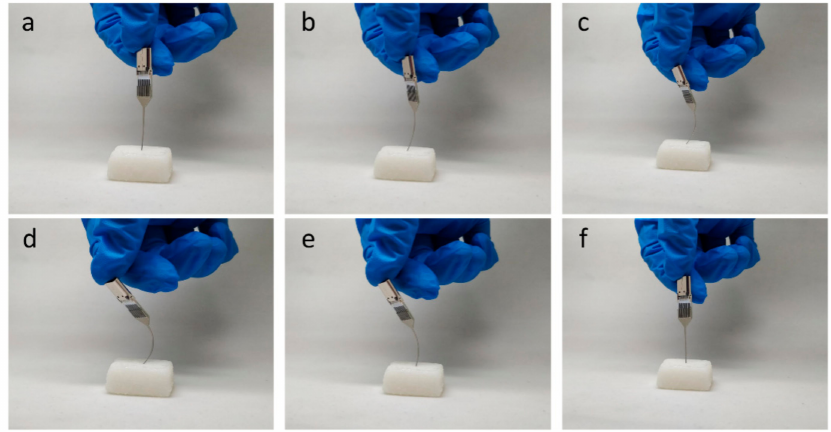
Figure 9. Photographs for the elasticity test of an as-fabricated microprobe with a hard